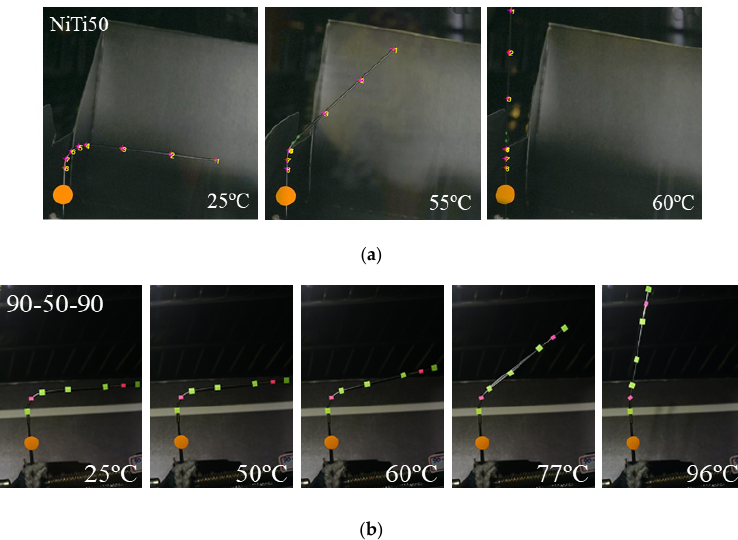
Figure 8. Shape recovery of specimens depending on austenite temperature: ( a ) single wire and ( b ) hybrid wire. ( b ) hybrid